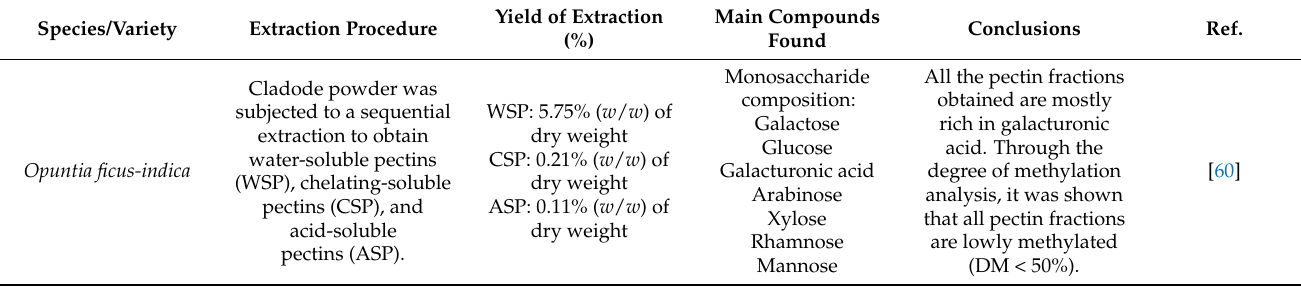
Table 2. Mucilage and pectin extraction procedures, yields, and compositions from cladodes of Opuntia